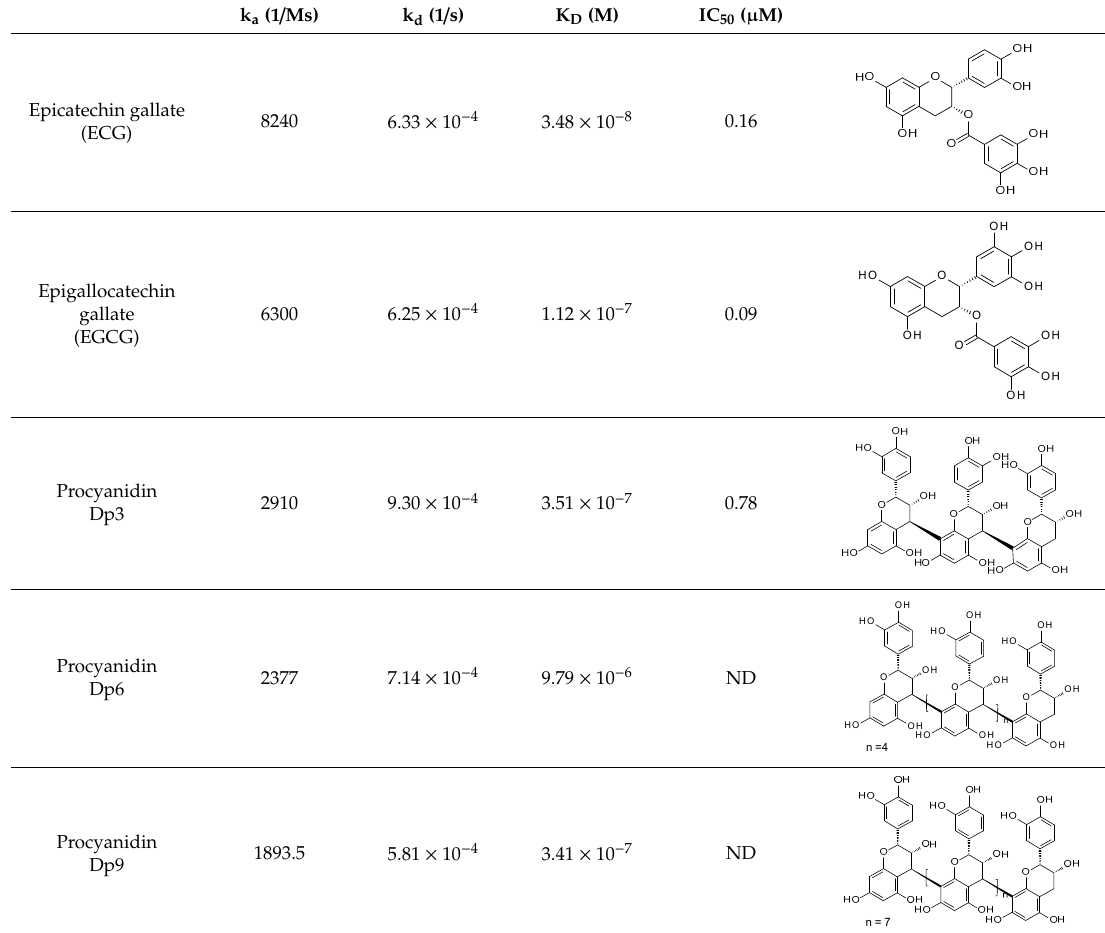
Epicatechin gallate